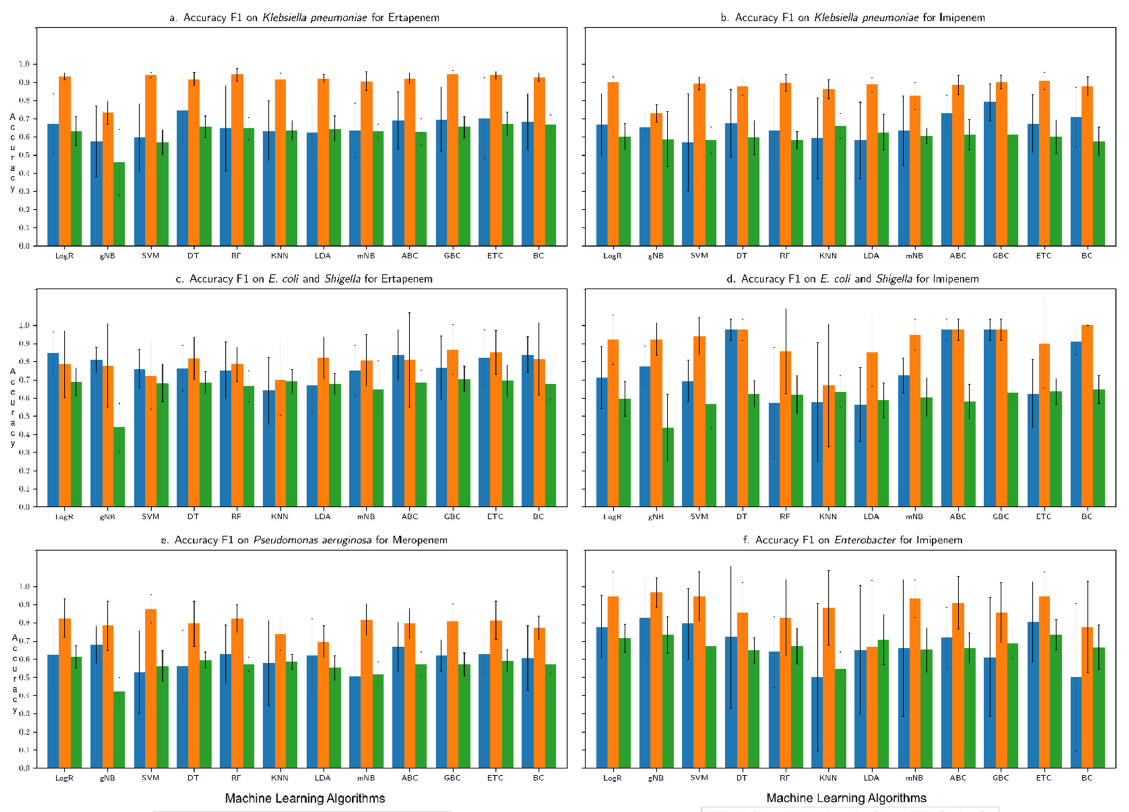
Figure 3. Overall accuracy (F1 score) produced by different machine learning algorithms in predicting resistance to Meropenem for ( a ) K. pneumoniae , ( b ) E. coli and Shigella , and ( c ) Enterobacter . “All Set” denotes all genes of a genome of interest, “Intersection Set” contains genes that consistently ranked high in their importance in discriminating resistant from susceptible strains in each round of cross-validation, and “Random Set” contains randomly sampled genes from All Set (same number of genes as in Intersection Set). Performance was assessed for each of three input datasets in a 6-fold cross-validation setting.